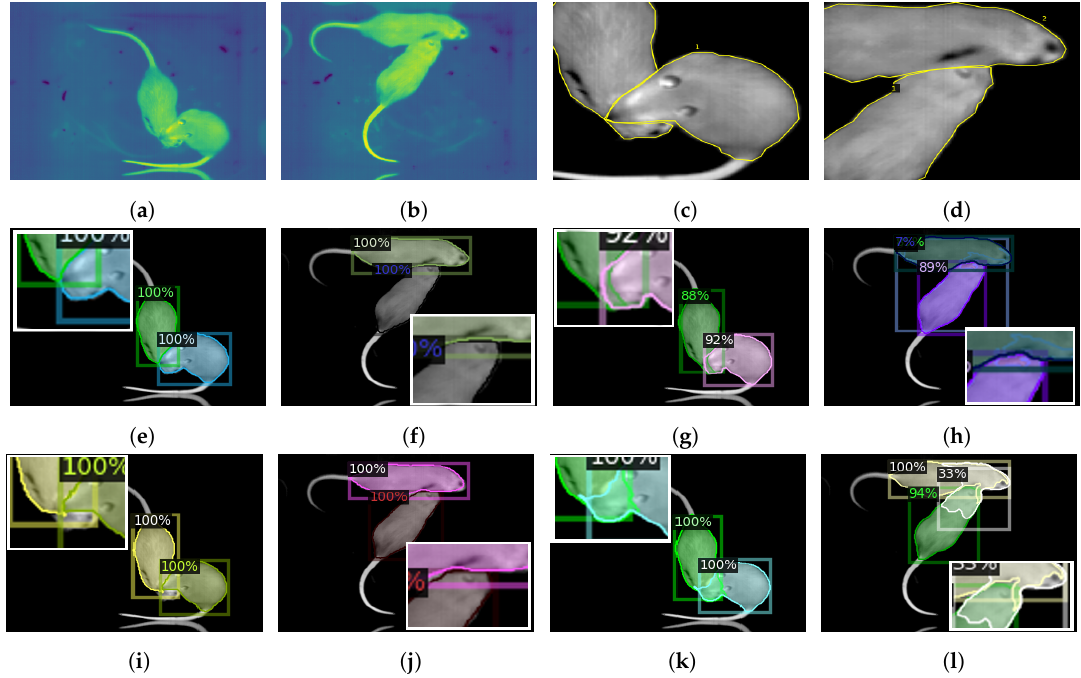
Figure 3. Examples of segmentation and detection prediction made for ( a , b ) the original images; ( c , d ) proper segmentation zoomed and marked with yellow lines. Results for: ( e , f ) pre-trained Mask R-CNN; ( g , h ) pre-trained TensorMask; ( i , j ) random initialized Mask R-CNN; ( k , l ) random initialized TensorMask.